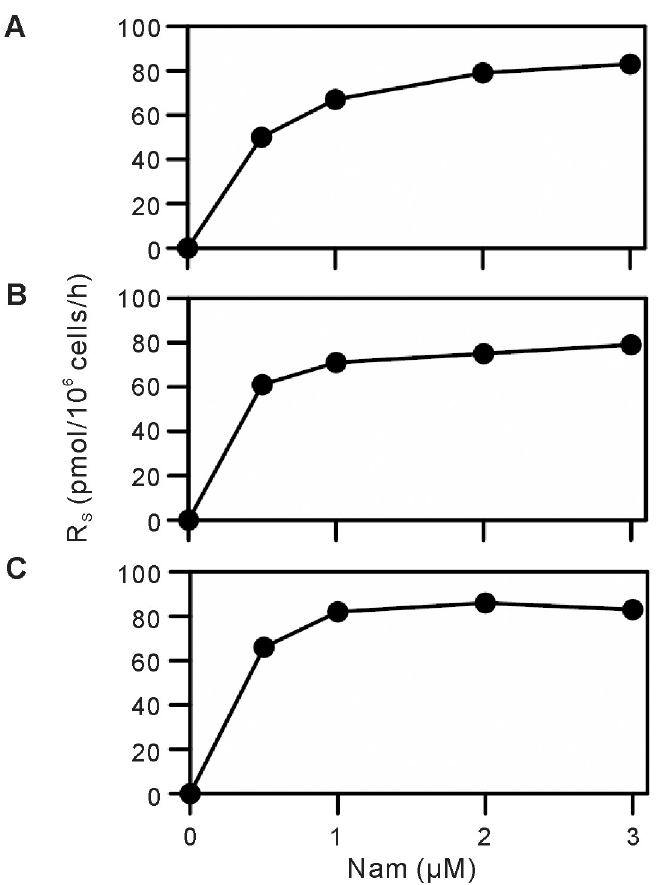
Fig 3. The effect of concentrations of d4-Nam in medium on R S . Fao (A), HepG2 (B), and HeLa (C) cells were incubated with d0-Nam-free MEM supplemented with indicated concentrations of d4-Nam for 3 h. After the incubation, d3-NAD + was quantified to determine R S ( circles